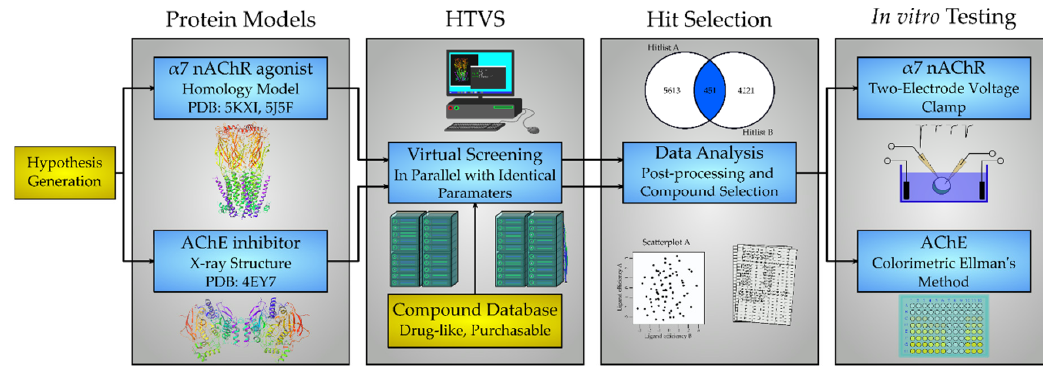
Figure 2. Workflow of the parallel HTVS, hit selection and in vitro evaluation. Two protein targets were selected for in silico studies and protein models suitable for docking prepared. The same database of compounds was then individually screened against each model using identical parameters. After post-processing, common compounds from the two independent screening hit lists were used to identify compounds destined for in vitro testing.